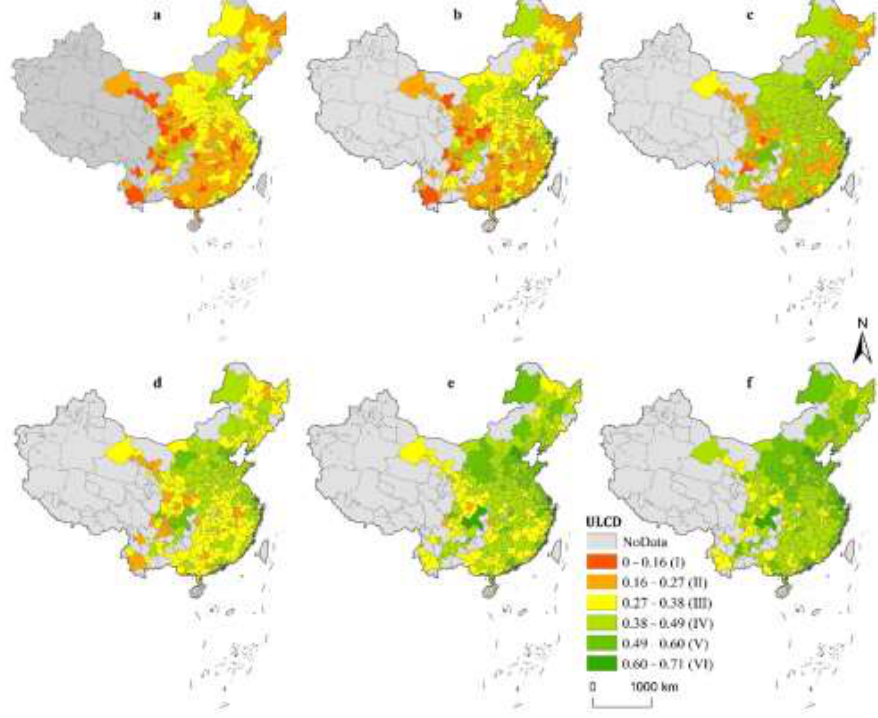
Figure 1. Spatio-temporal characteristics of the ULCD level of 282 cities in China (( a ): 2004; ( b ): 2008;